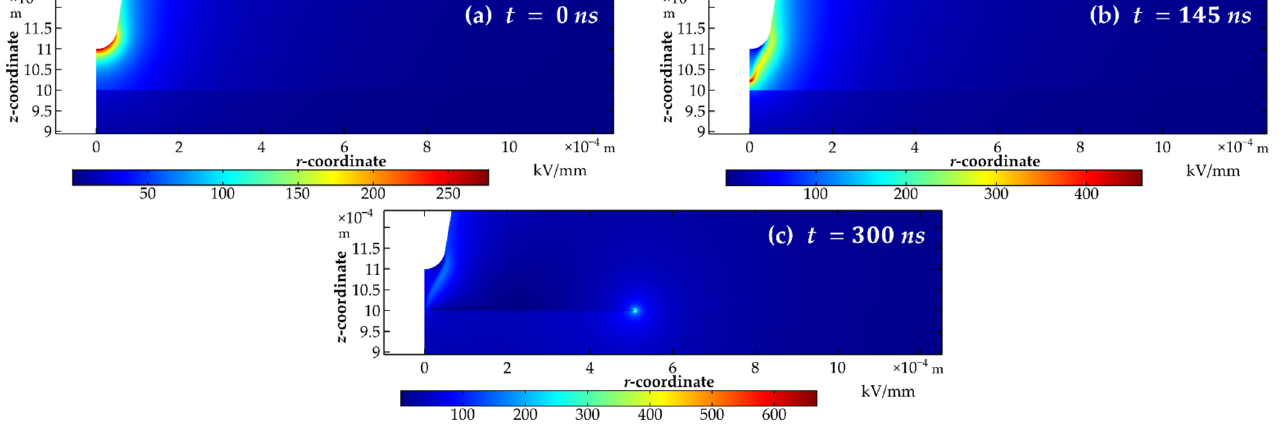
Figure 7. Two-dimensional plane distribution of the electric field magnitude (kV/mm) in the 1st case at three instants: ( a ) 0 ns; ( b ) 150 ns; ( c ) 200 at three instants: ( a ) 0 ns; ( b ) 150 ns; ( c ) 200 ns.